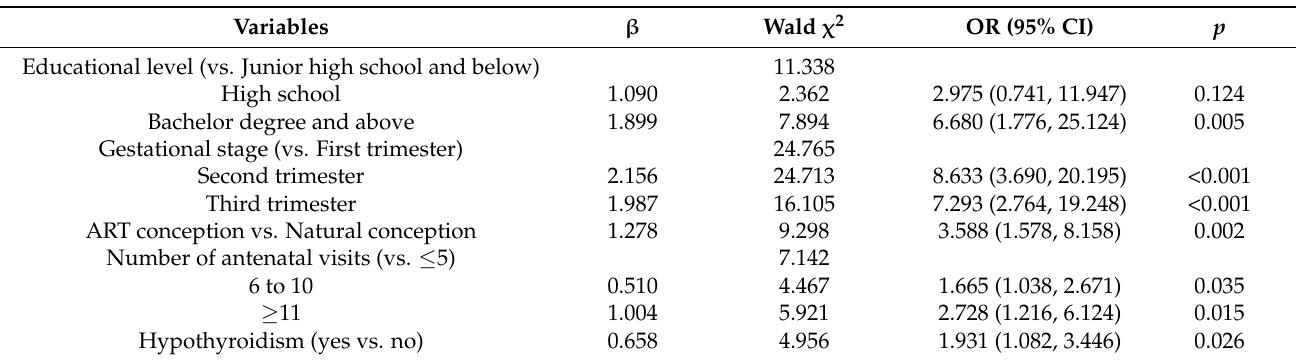
Table 4. Logistic regression analysis results of factors related to pregnant women using multiple dietary supplements